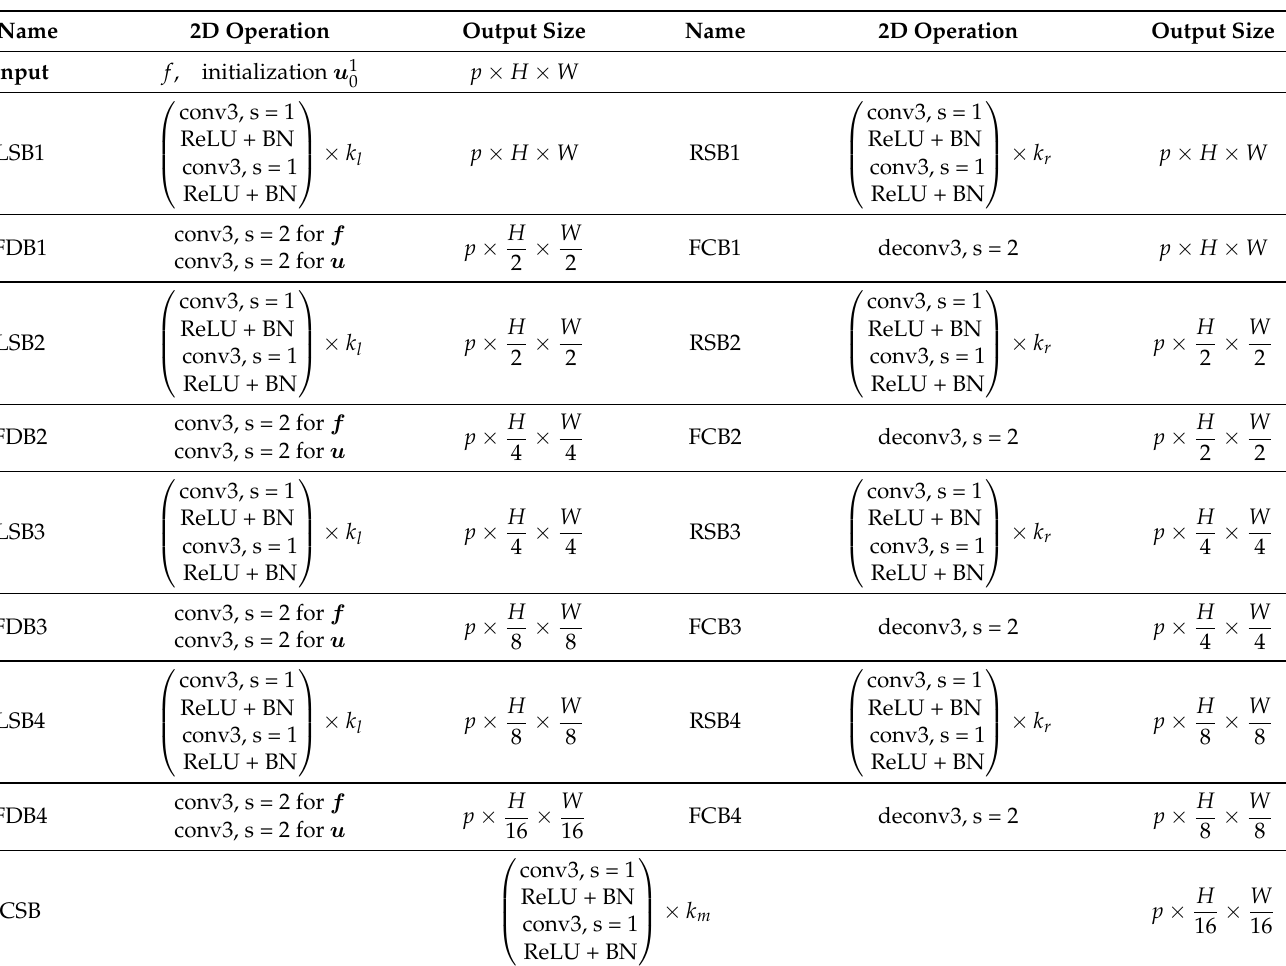
Table 1. A standard configuration of the proposed 2D FAS-UNet. p × H × W denotes the number of channels and the height and width of the feature maps, respectively. “conv3, s = 1 or 2” indicates the convolution with a kernel size of 3 × 3 and the stride of convolution being 1 or 2, respectively. ReLU and BN are the ReLU activation function and batch